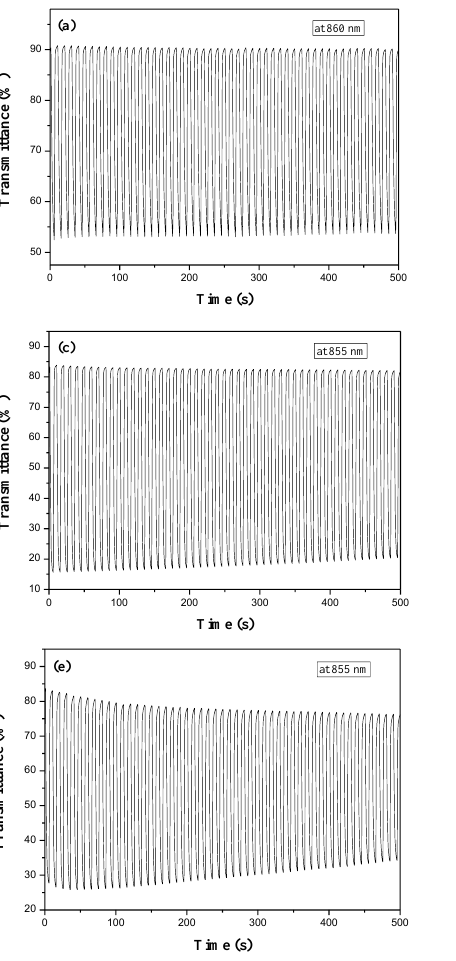
Figure 6. Optical contrast of ( a ) PDTC, ( b ) P(DTC- co -BTP), ( c ) P(DTC- co -BTP2), ( d ) P(DTC- co -TF), and ( e ) P(DTC- co -TF2) in 0.2 M LiClO 4 /ACN solution with a residence time of 5 s. Table 3. Optical properties of electrodes.